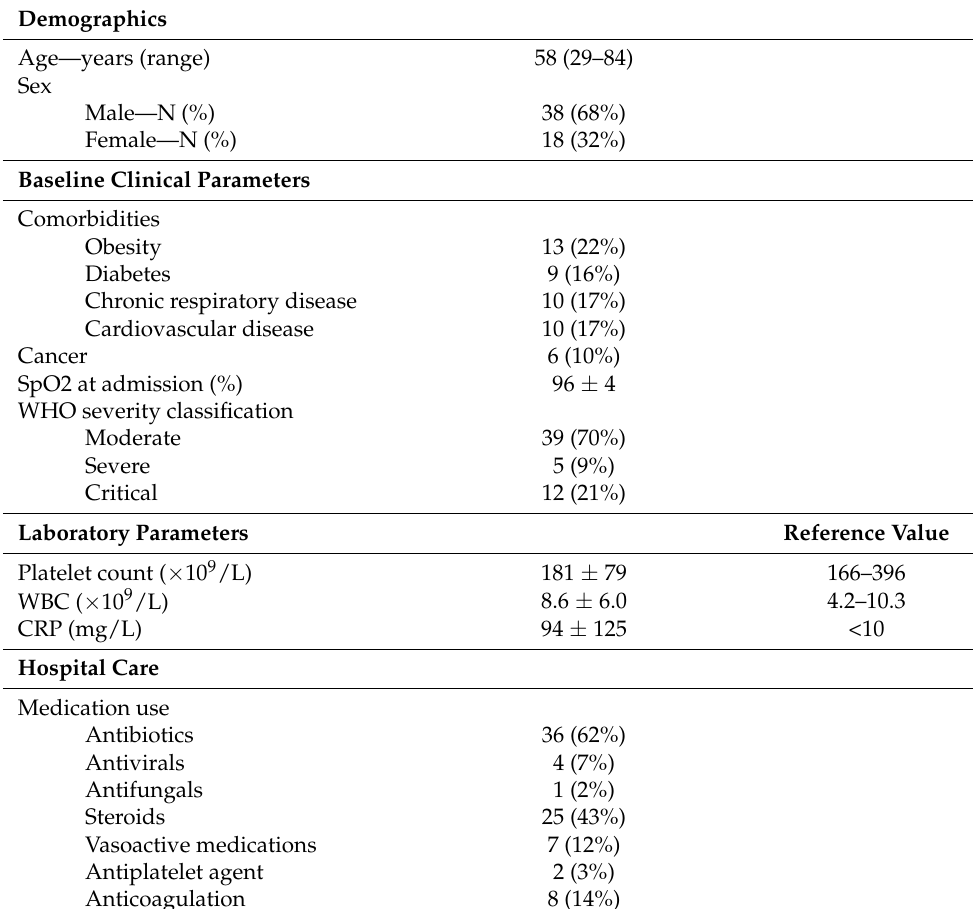
Table 1. Clinical and biological characteristics of COVID-19 patients (N =